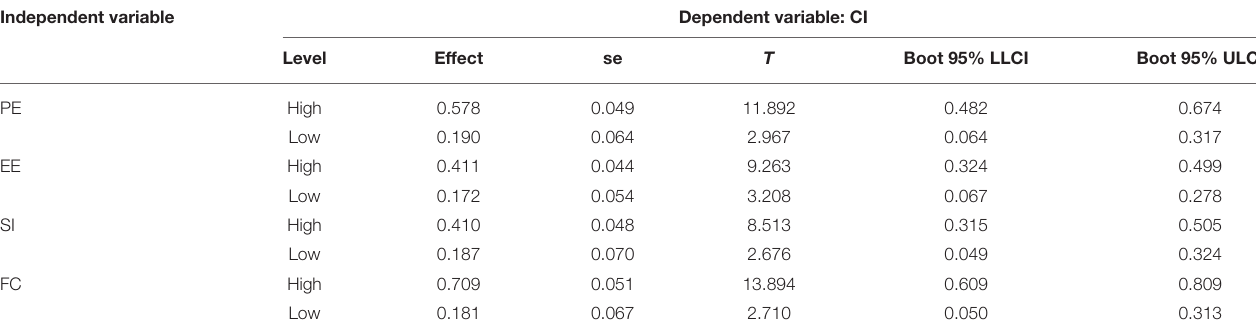
TABLE 8 | Conditional effects of the focal predictor at high and low levels of the moderator CCC. Independent